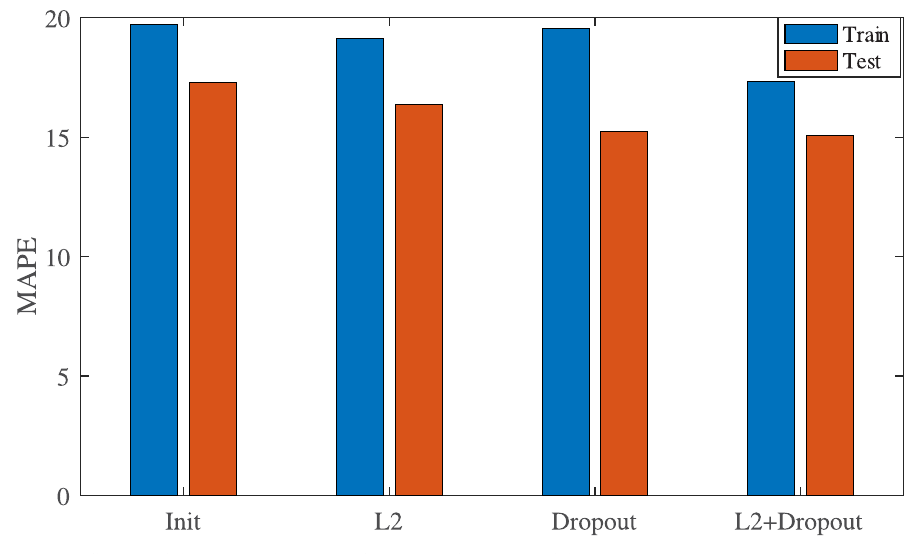
Fig 6. Influence of dropout and L2 on performance of LSTM model.